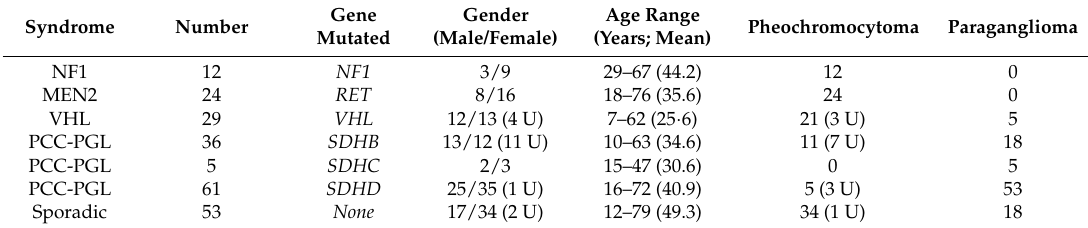
Table 5. Proportion of age and gender in hereditary PPGLs with